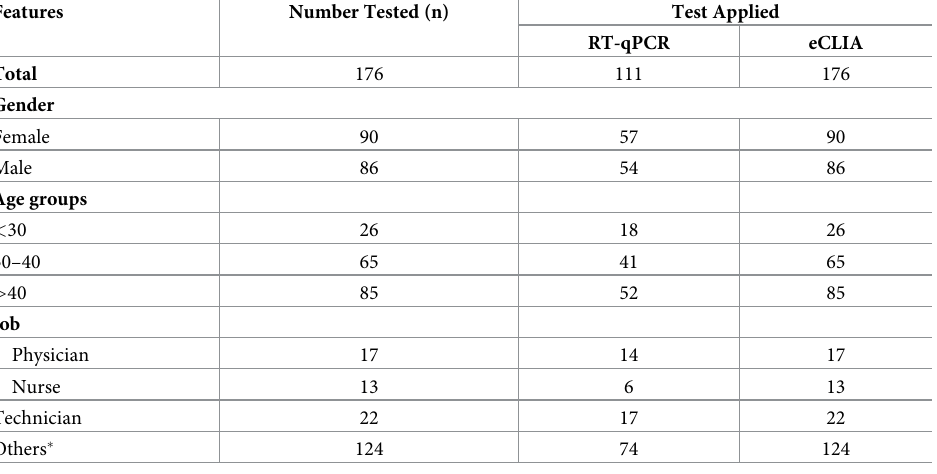
Table 1. The demographic distribution of healthcare workers who voluntarily participated in the current study according to gender, job type and age.